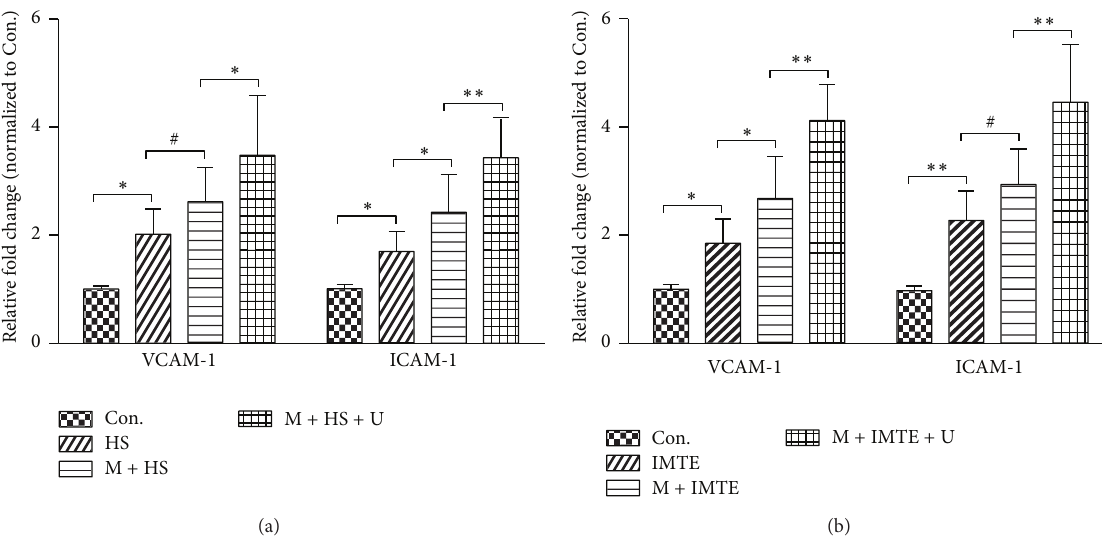
Figure 2: Effect of UTMD on the expression of VCAM-1 and ICAM-1. (a) The expression of VCAM-1 and ICAM-1 in the supernatant groups. (b) The expression of VCAM-1 and ICAM-1 in the MTE from each group. All values are expressed as the mean ± SD. ∗ 𝑃 < 0.05 ; ∗∗ 𝑃 < 0.01 ; # 𝑃 > 0.05 ; 𝑛 = 6